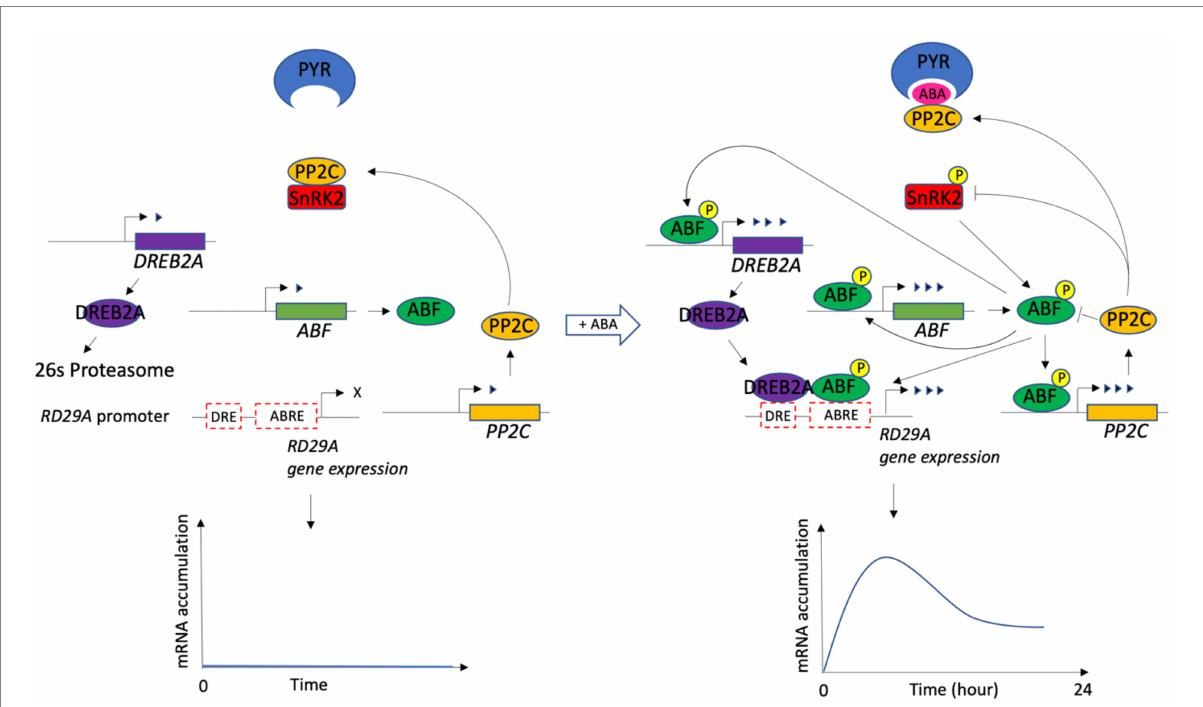
FIGURE 1 Schematic drawing of the ABA signaling pathway for the RD29A expression. ABA signaling core components and their interactions are shown with and without ABA. In the presence of ABA, downstream regulators ABF and DREB2A bind ABRE and DRE, the cis -elements on the RD29A gene, leading to its transient expression. The drawing was modified from the figure in (Wang et al., 2019). P with a circle represents the phosphorylation of a protein. A different number of arrowheads indicates a different level of gene expression. X indicates no gene